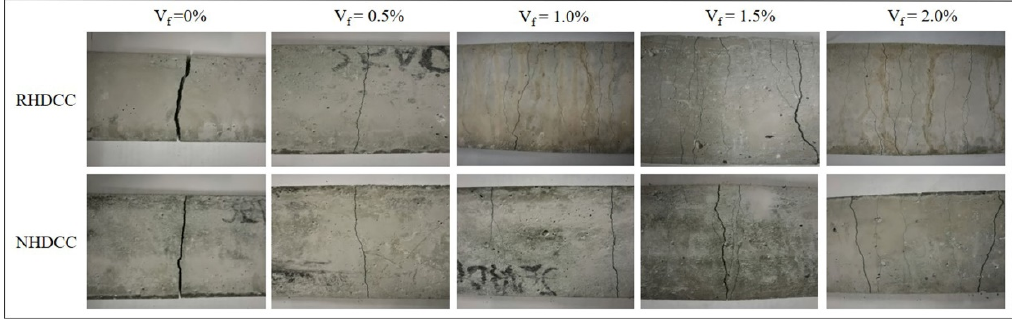
Figure 11. Bottom surface of specimens after bending failure.